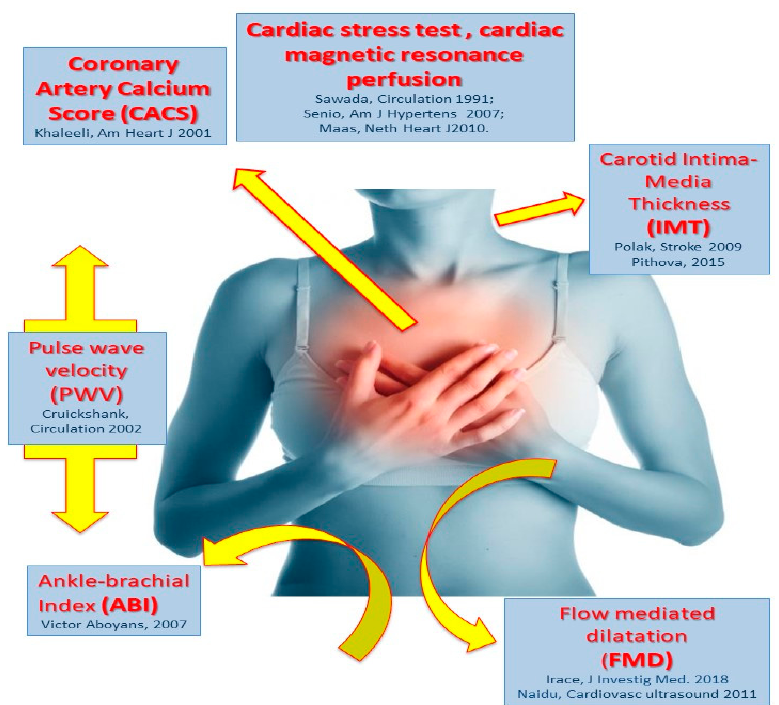
Figure 2. Noninvasive assessment of coronary artery disease in diabetic women. Although the risk of heart disease in diabetic women may emerge before menopause, detection and evaluation of CAD are di ffi cult, due to the lower sensitivity and specificity of biomarker assays in